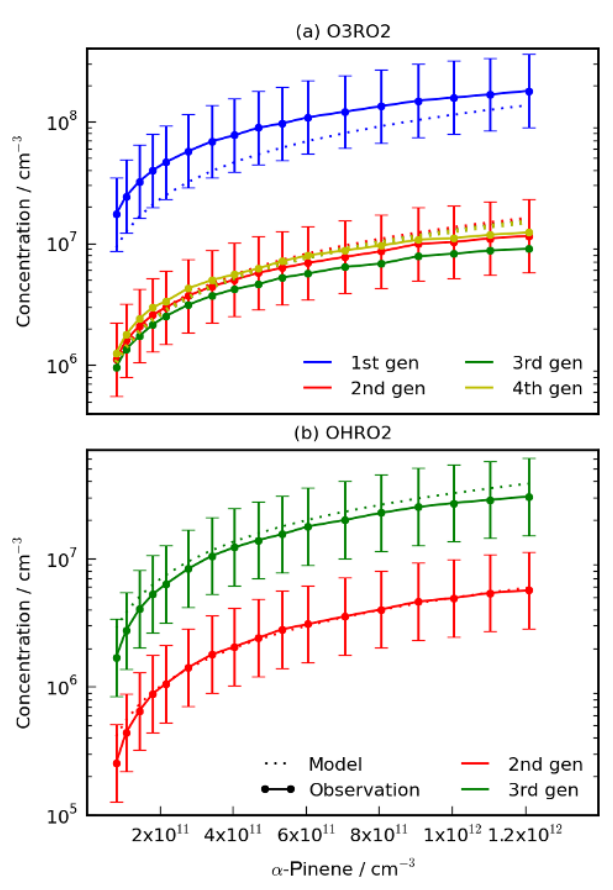
Figure 3. Comparison of the HOM-precursors (a) O3RO2 and (b) OHRO2 produced by the model and from Berndt et al. (2018a) for experiments performed with different initial concentrations of α -pinene (Simulation A). The model reproduces the increase in O3RO2 and second- and third-generation OHRO2 with initial α - pinene well. The model struggled to reproduce concentrations of the first-generation OHRO2 (not shown). Note that the error shown is the experimental error from Berndt et al. (2018a) and the error bars for the third- and fourth-generation O3RO2 species are of a very similar size to the error bars of the second-generation species but have been omitted for clarity.